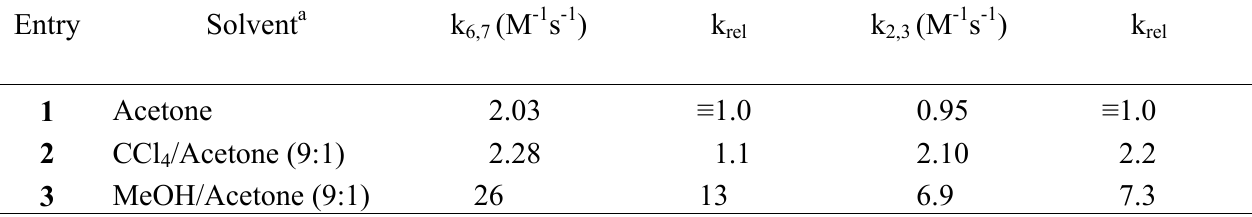
Table 3. Calculated second order rate constants of epoxidation of 6,7 and 2,3 sites of geraniol at 23